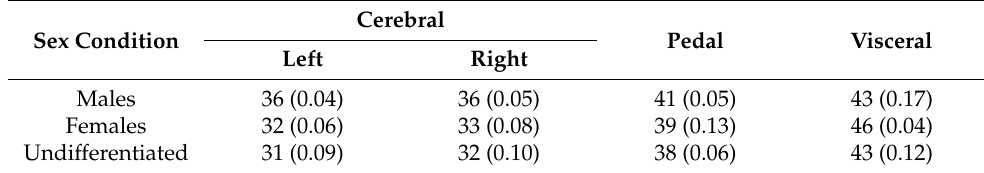
Six animals per sex condition were used. Data given as mean (coefficient of variation). Table 4. Relative volumes (%) of the cerebral, pedal and visceral ganglia medulla of S. plana . Sex Condition